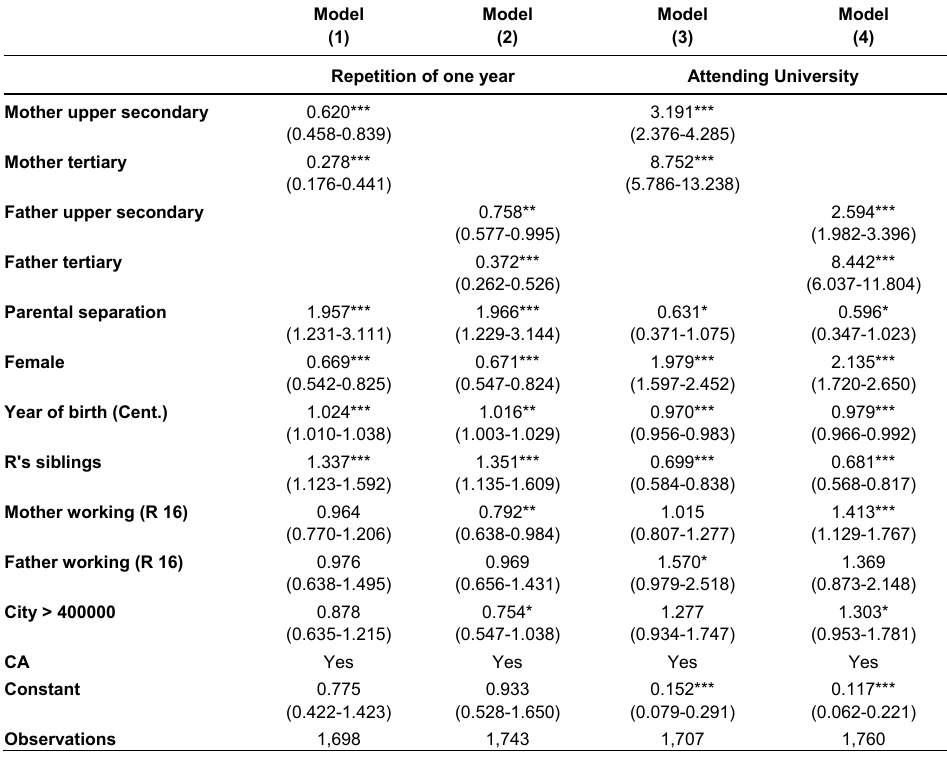
Table A.1 : Logit models of repeating one year at school and attending university after parental separation by mother and father education